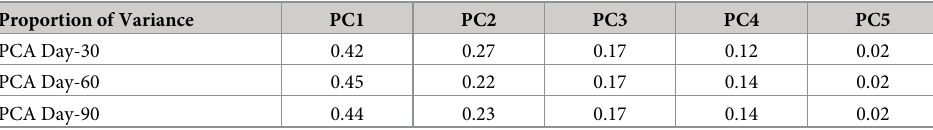
Table 2. Proportion of variance explained from PCA analysis.